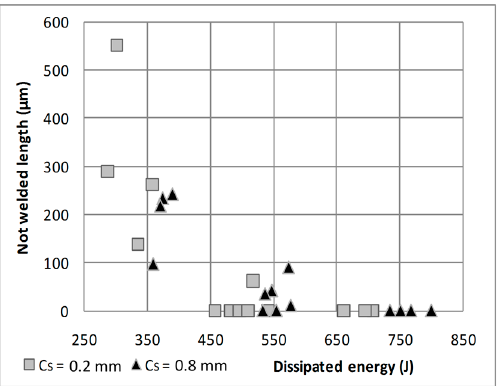
Figure 8. Not welded length as a function of the dissipated energy for 32 experiments.